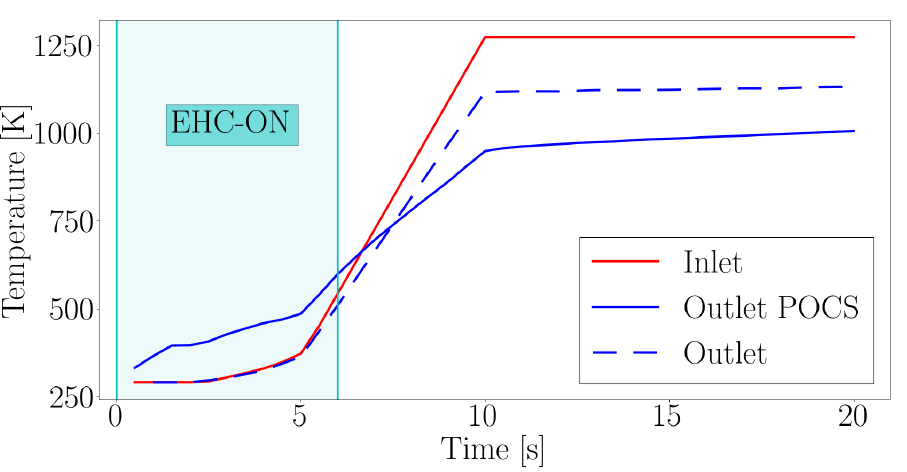
Figure 14. EHC–POCS influence on the fluid temperature profile.